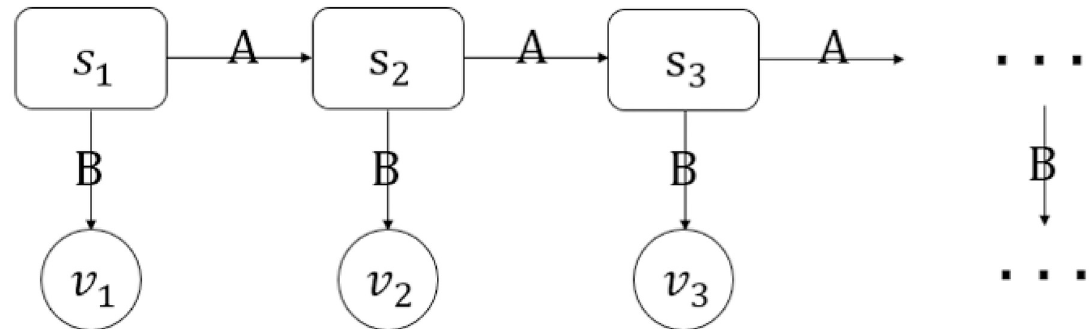
Fig 1. The structure of the Hidden Markov Model (HMM) that we build as the